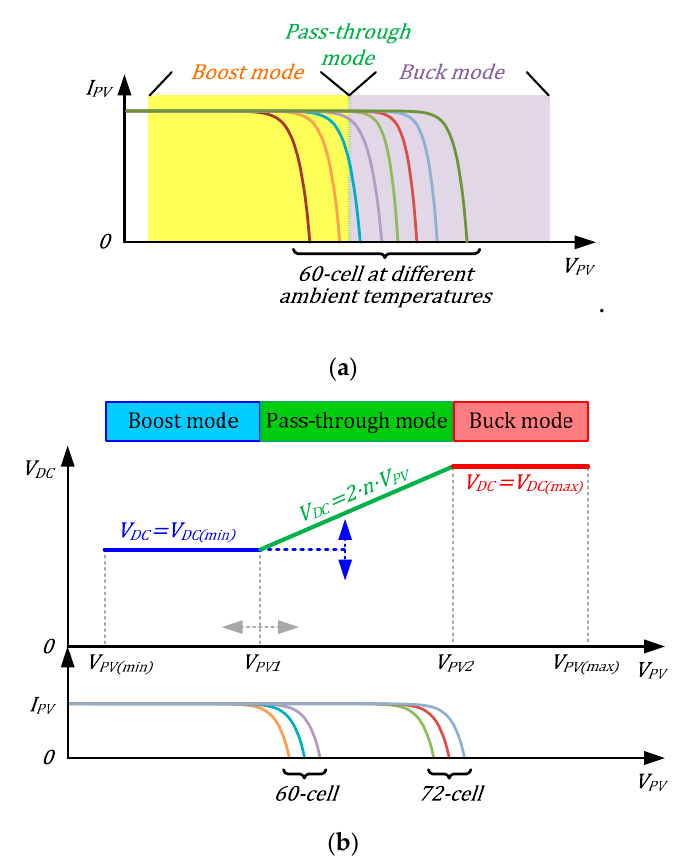
Figure 2. Utilization of operating modes of a front-end galvanically isolated buck-boost dc/dc converter at fixed ( a ) and variable and ( b ) dc-link voltage, including different PV module characteristics.